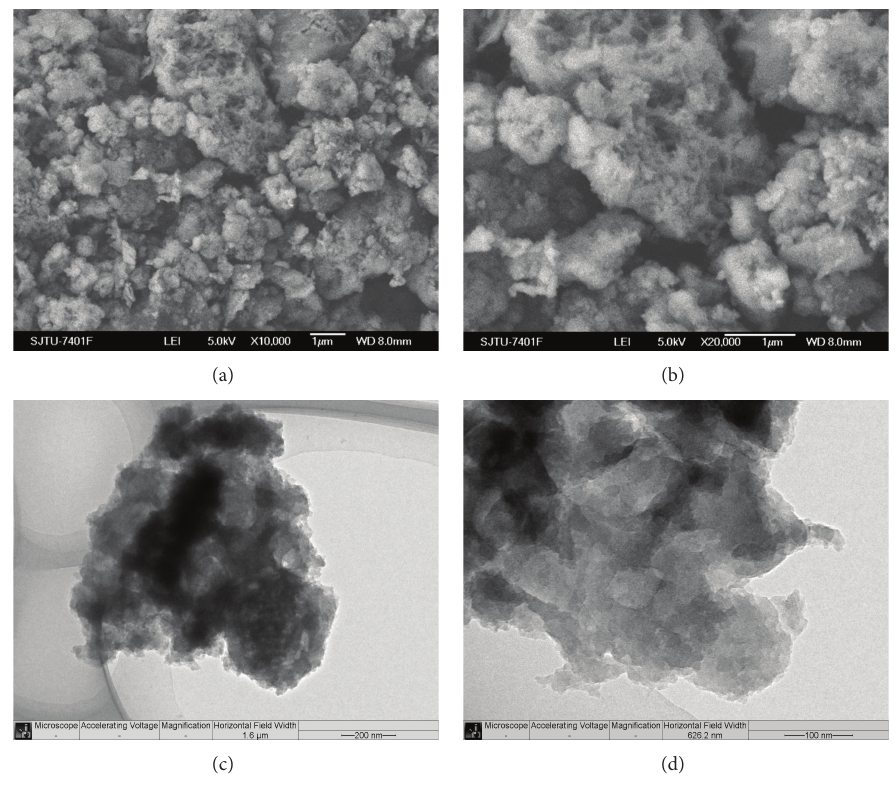
Figure 6: SEM (a and b) and TEM (c and d) images of carbyne polysulfide.